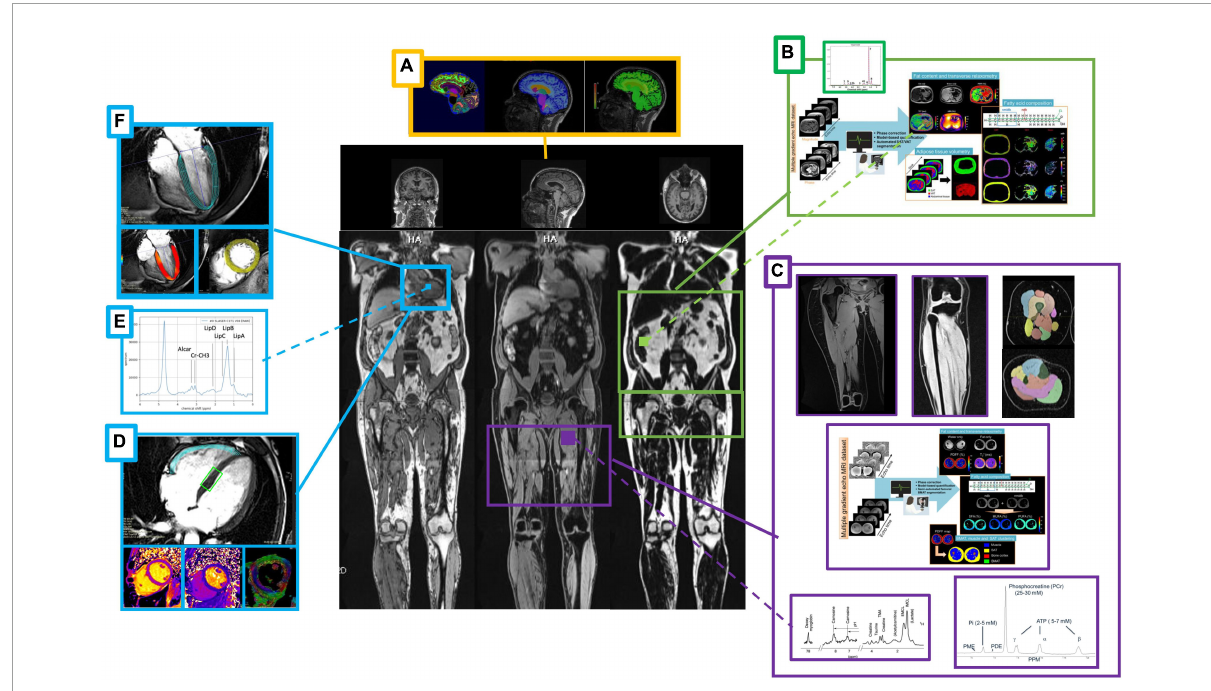
FIGURE3 Summary of the magnetic resonance imaging/spectroscopy (MRI/MRS) measurements. Body composition after a 12 days fasting period by means of MRI/MRS scans with a focus on the brain (A) , liver (B) , skeletal muscle (C) , and myocardium (D–F) . Beyond brain morphometry (A) , myocardial mass, function and regional deformation (F) , and abdominal organs sizing (B) calculated from localized dedicated scans (side panels). Subcutaneous, visceral, extra-visceral and bone marrow fat quantification and total lean mass will be calculated from whole body acquisition (middle panel). MR spectroscopy of the liver (B) , leg muscle (C) , and heart (E) allows complementary fat decomposition, triglycerides and metabolites concentrations quantification. Advanced myocardium tissue characterization will include relaxometry and diffusion parameters mapping, as well as myocardial fiber orientation and local deformation (D) . Muscle legs volume and strength (maximum voluntary contraction) will be compared to MRS 31P data and extracted biomarkers of the oxidative metabolism (C)